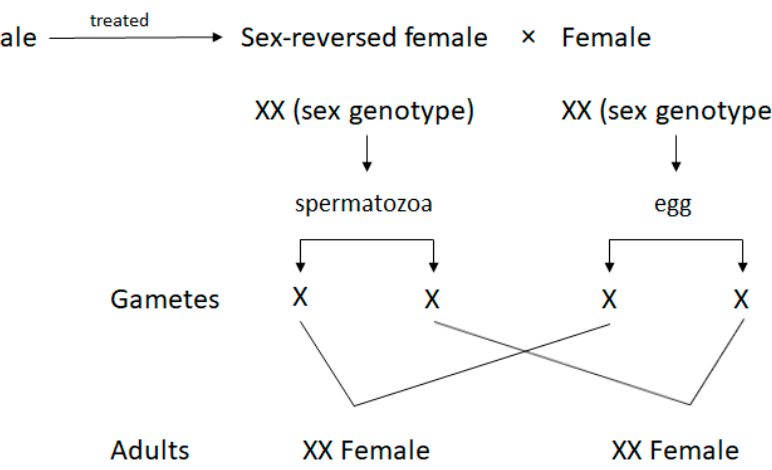
Figure 1. Mating of sex-reversed female with normal female, showing all-female fish.